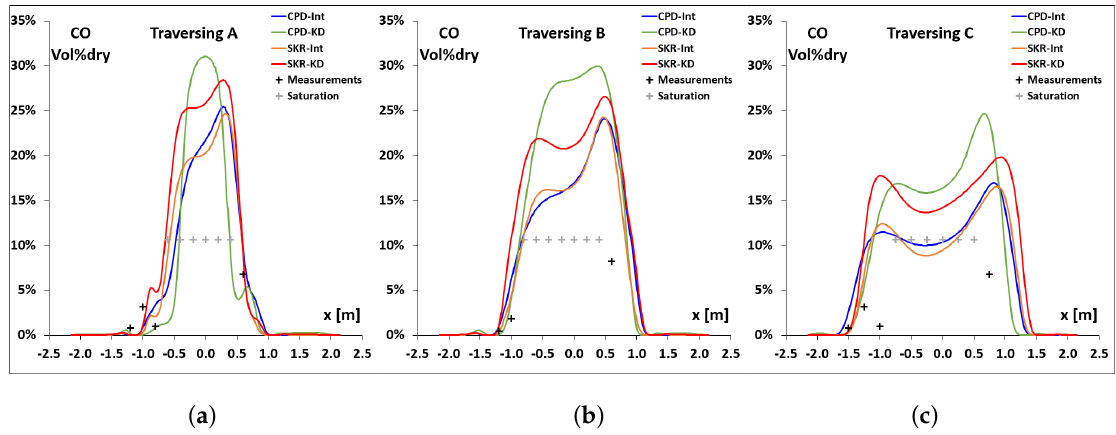
Figure 16. CO molar concentrations distribution along Traverses A ( a ), B ( b ) and C ( c ).